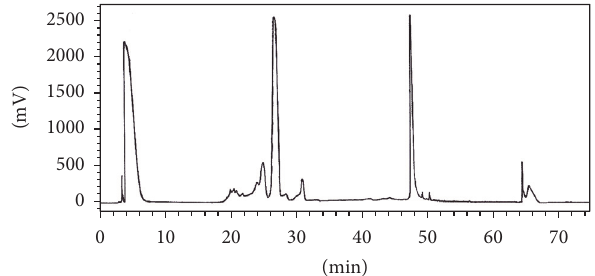
Figure 4: HPLC chromatogram detected at 254 nm for the crude extract of S. chinensis